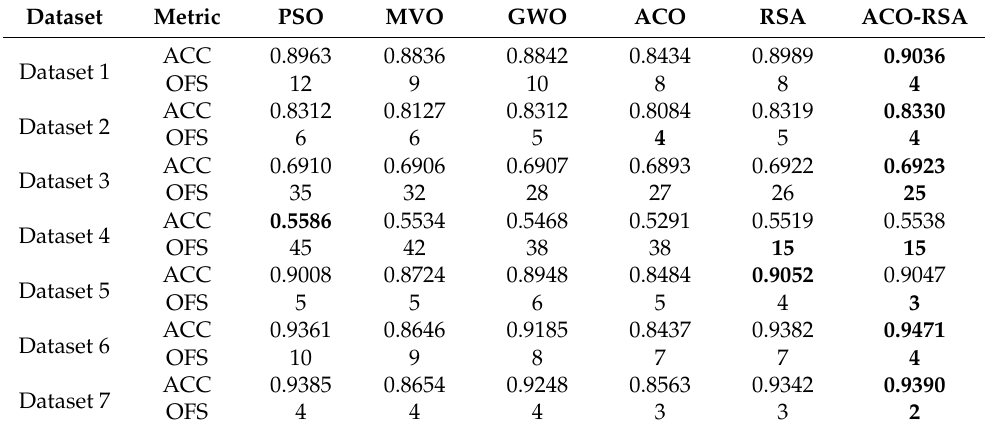
Table 3. The average results obtained by different algorithms in terms of the accuracy and OFS.